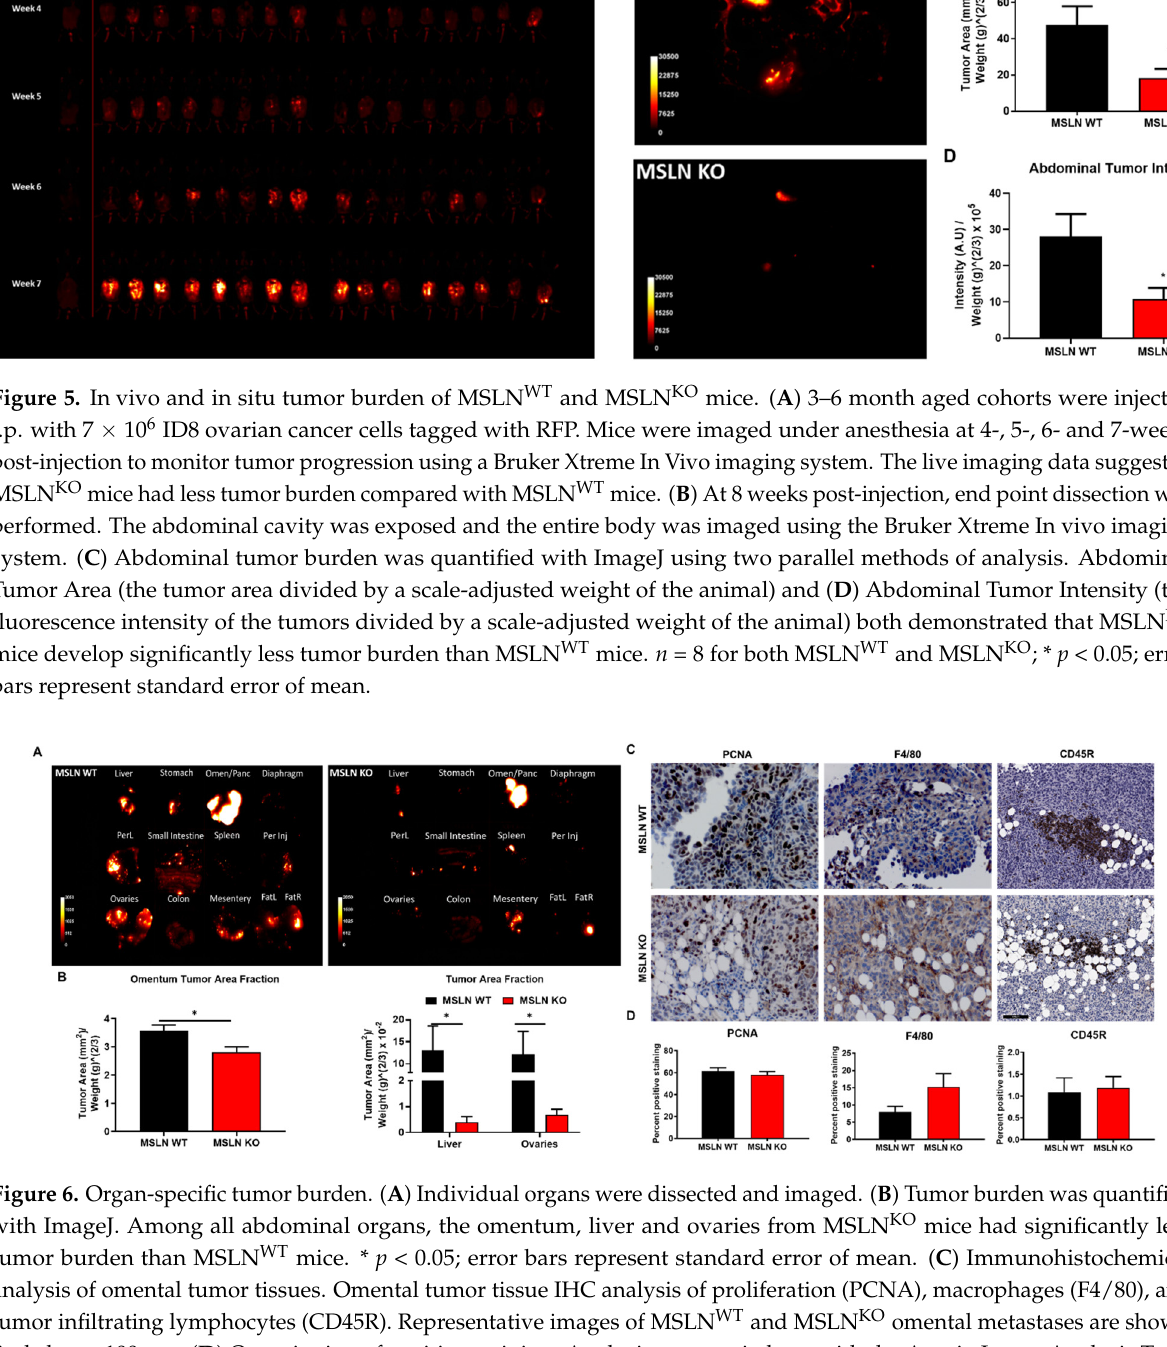
Figure 6. Organ-specific tumor burden. ( A ) Individual organs were dissected and imaged. ( B ) Tumor burden was quanti- fied with ImageJ. Among all abdominal organs, the omentum, liver and ovaries from MSLN KO mice had significantly less